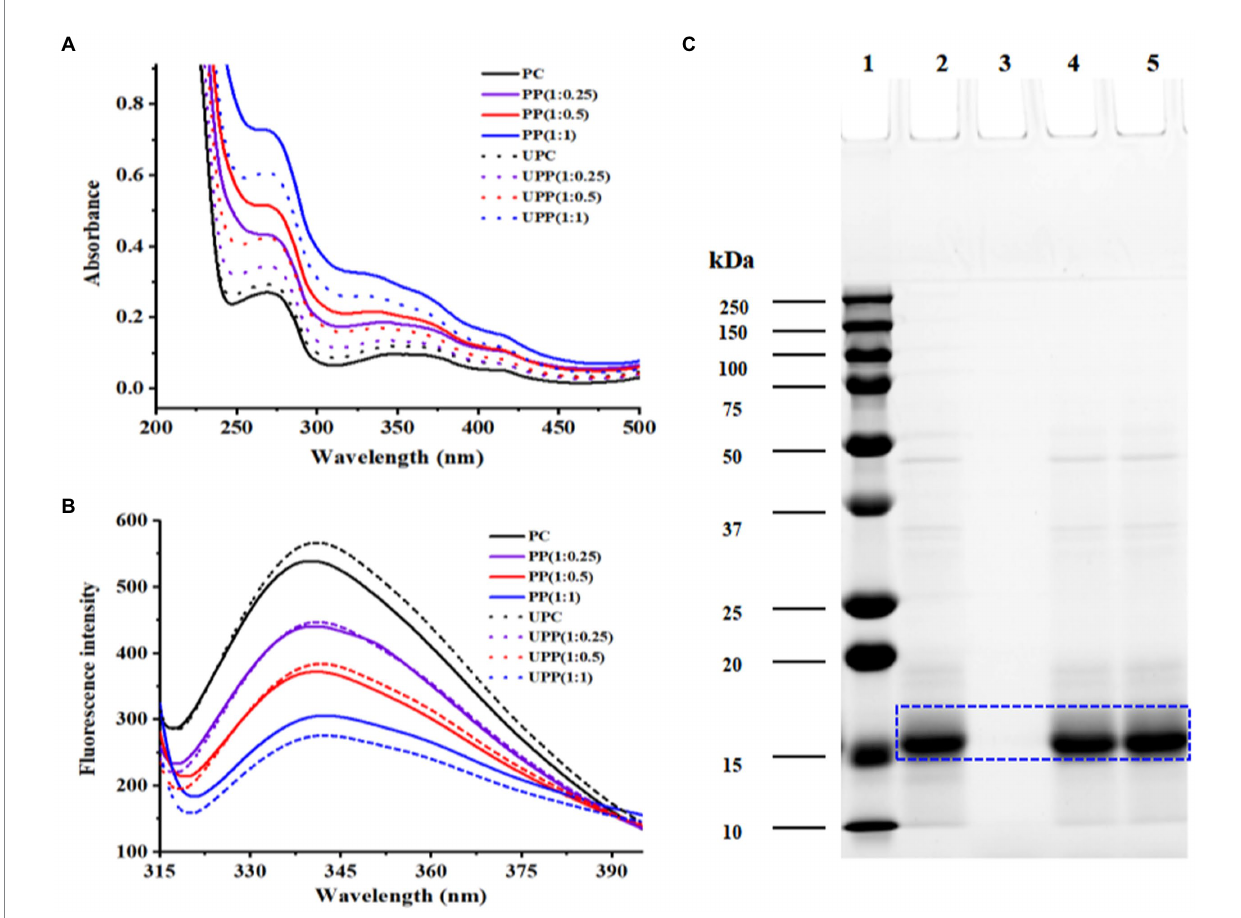
FIGURE 1 (A) UV–visible absorption spectra and (B) Fluorescence intensity of PC, PP (1:0.25), PP (1:0.5), PP (1:1), UPC, UPP (1:0.25), UPP (1:0.5), UPP (1:1), and (C) SDS-PAGE of 1-marker, 2-PC, 3-phlorotannin, 4-PP (1:1), 5-UPP